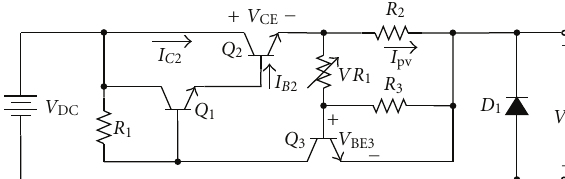
Figure 4: A test circuit for variable output characteristic simula- tions.